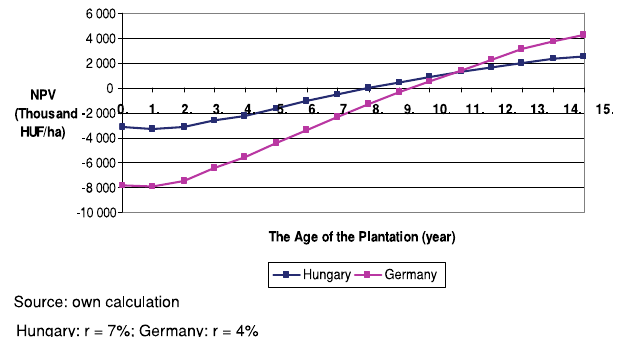
Figure 3. The NPV* in the Hungarian and German Apple Production